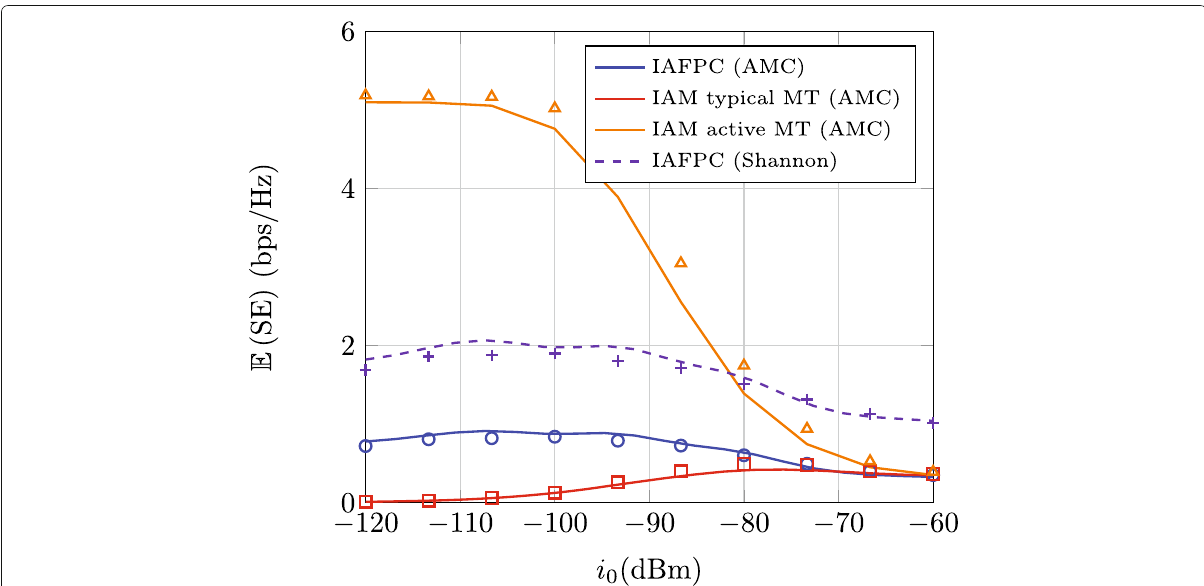
Fig. 7 Comparison of average SE of IAFPC and IAM for (cid:5) = 1, t ( 1 ) / t ( 2 ) = 9 dB and p max → ∞ . As for IAFPC, the average SE based on the Shannon formula is shown as well